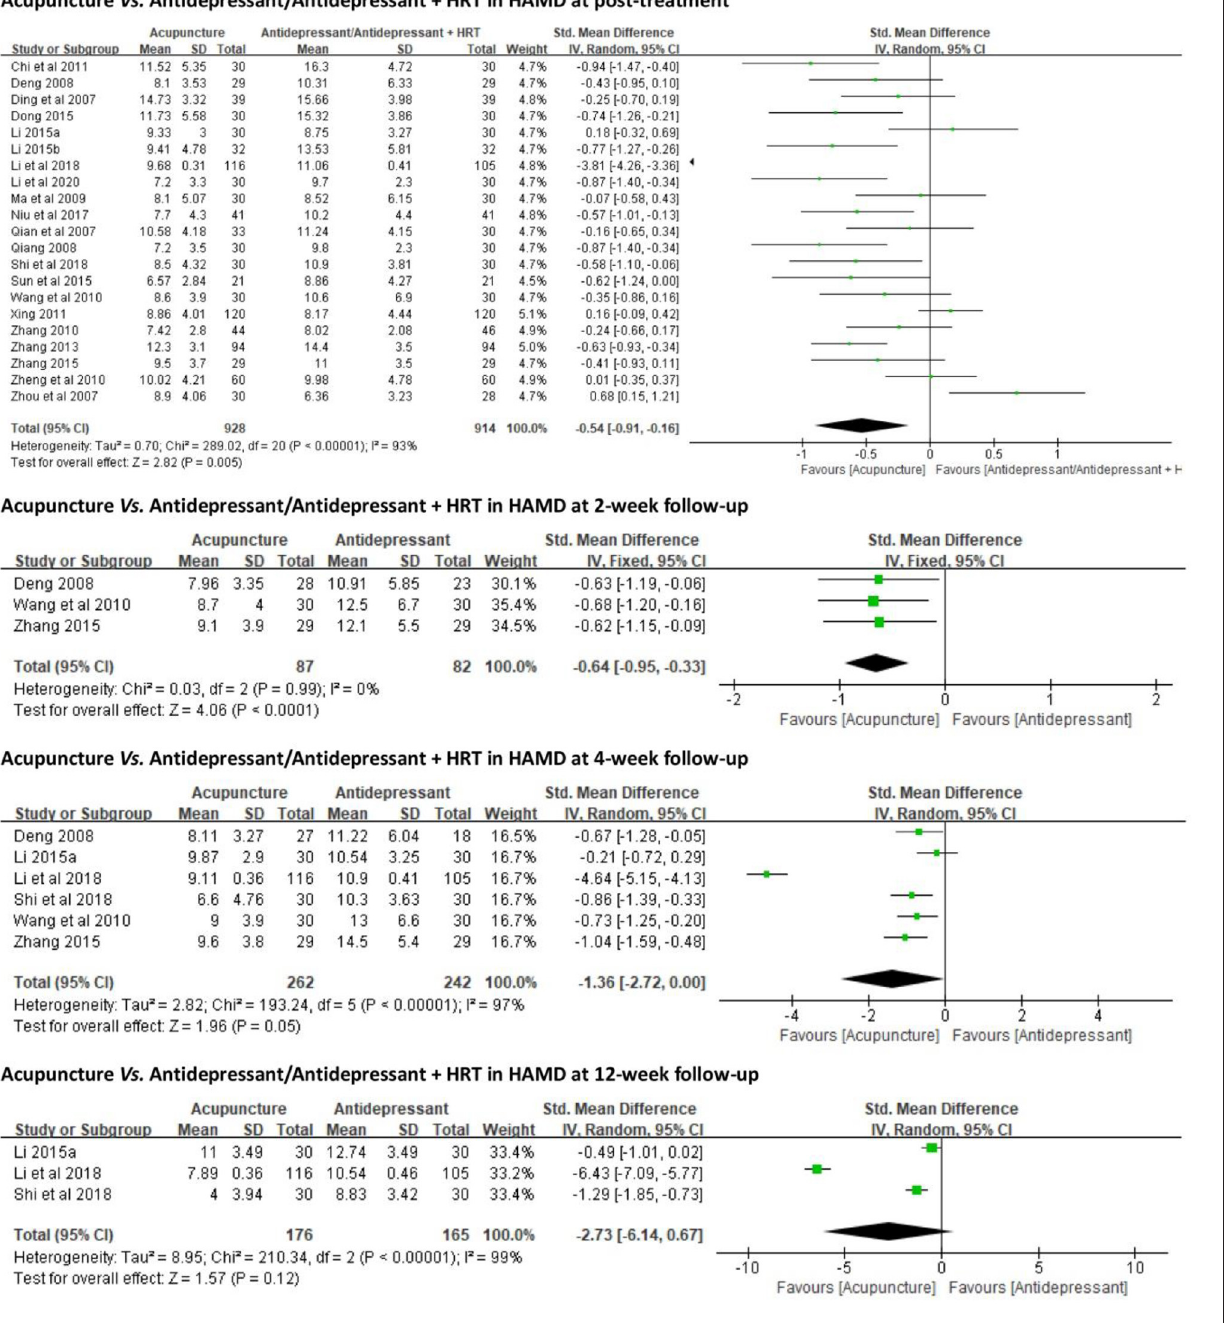
FIGURE 3 | Forest plots of acupuncture vs. antidepressant/antidepressant + HRT in HAMD. HRT, hormone replacement therapy; HAMD, Hamilton Depression